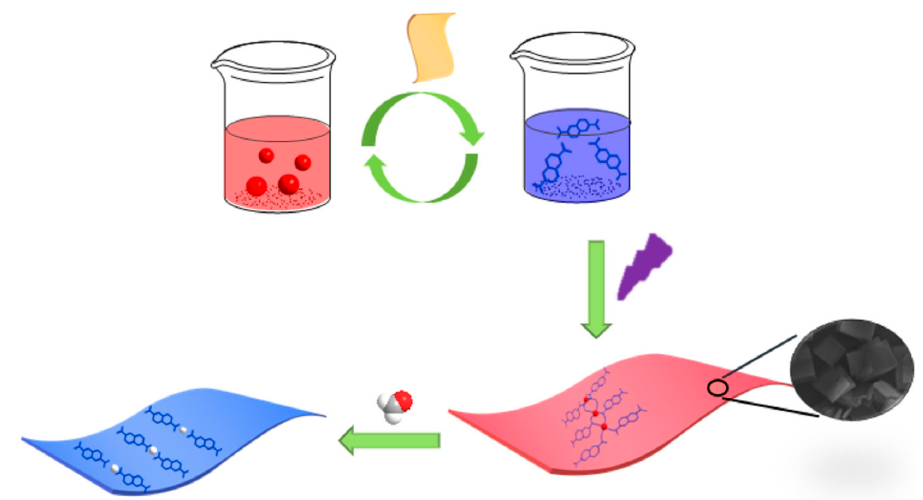
Figure 21. Schematic representation of the synthesis process of Eu-NDC@HPAN and the luminescence quenching phenomenon of HCHO to Eu-NDC@HPAN. Reprinted with permission from Reference [123]. Copyright 2017 Elsevier.